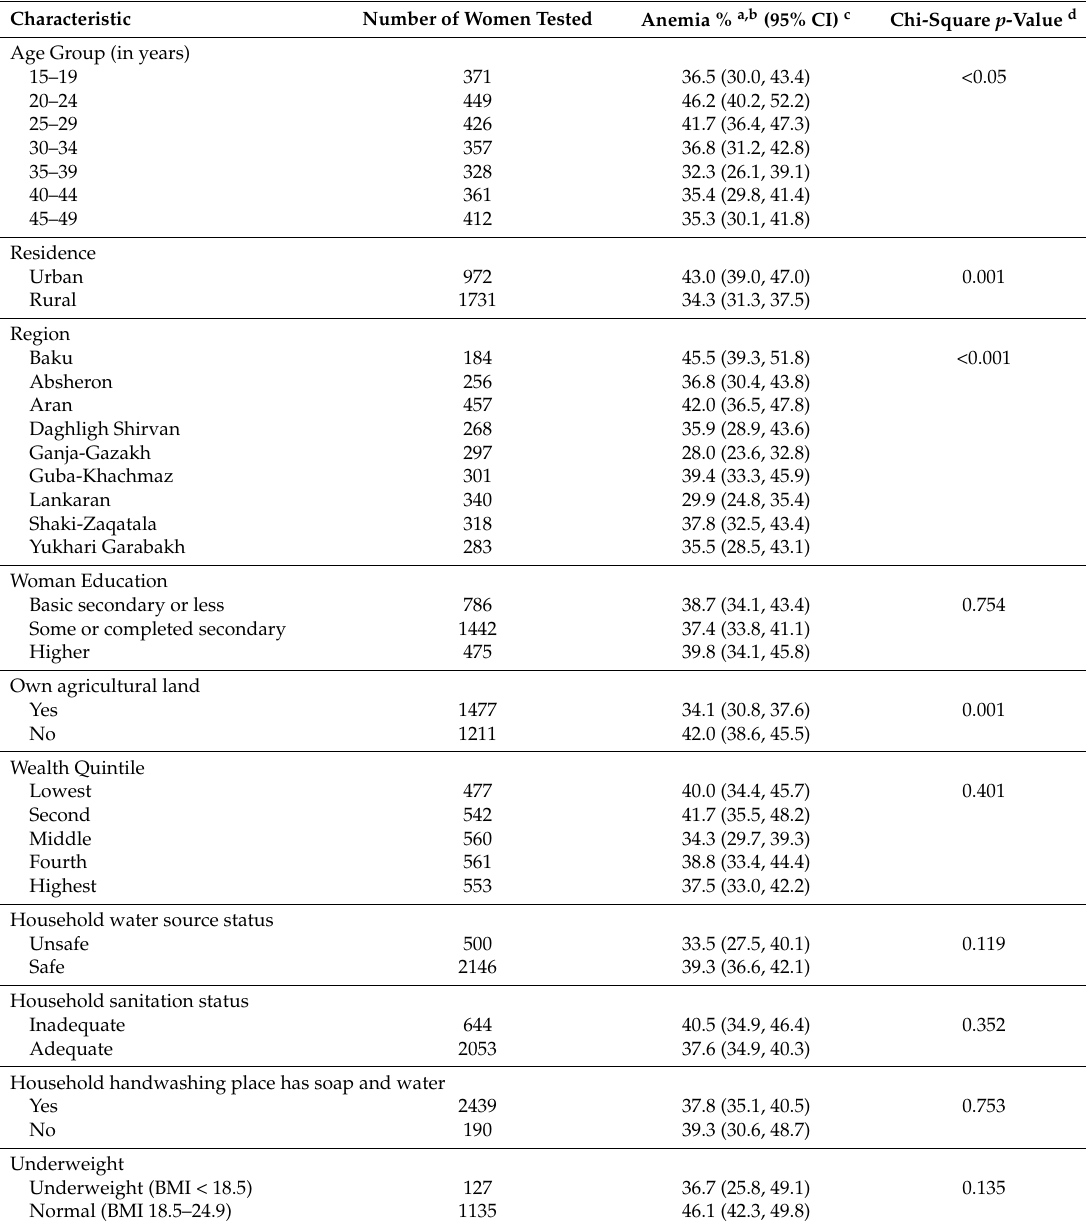
Table 4. Anemia prevalence in non-pregnant women 15–49 years by demographic characteristics and nutritional, disease, and environmental risk factors of anemia, Azerbaijan